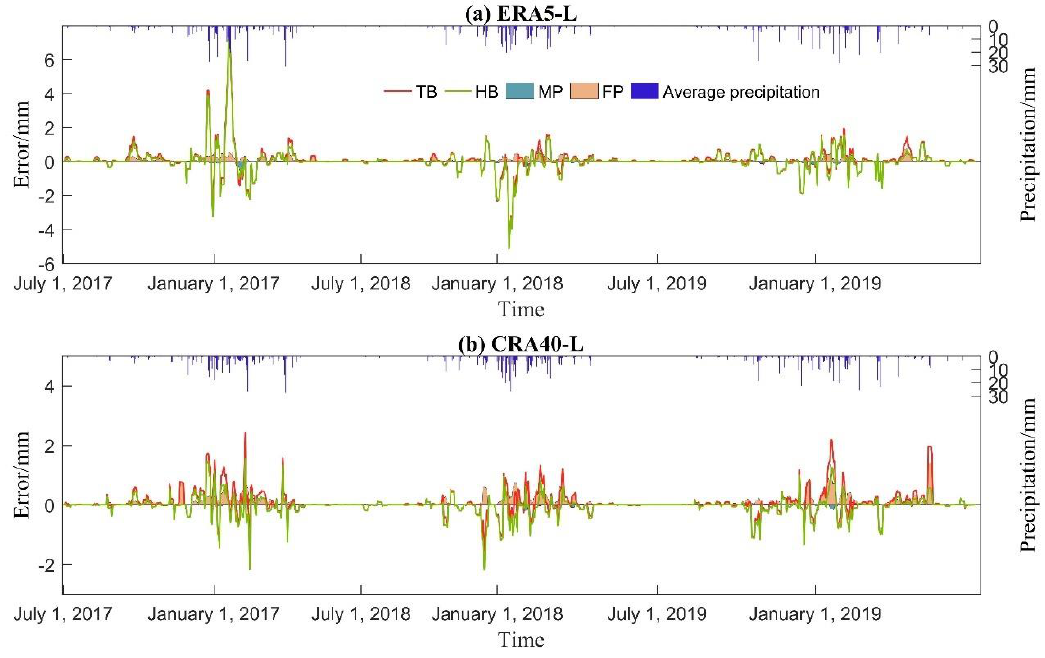
Figure 10. ( a, b ) Temporal variations of the error components, namely, TB , HB , MP , and FP .